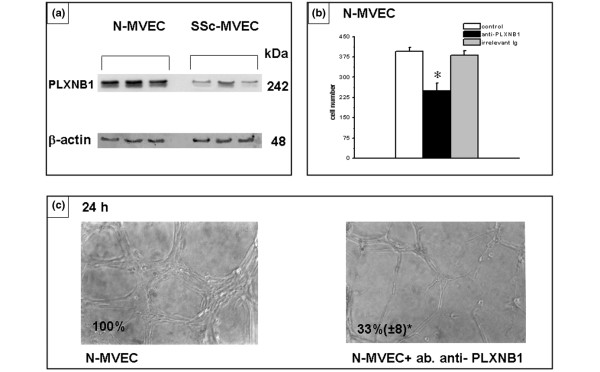
Expression and role of plexin B1 (PLXNB1) in endothelial cell invasion and capillary morphogenesis. (a) Western blotting of 60 μg protein from cell lysates of microvascular endothelial cells (MVECs) from normal subjects (N-MVECs) and patients with systemic sclerosis (SSc-MVECs) with anti-PLXNB1 antibodies. Each lane represents western blotting of MVECs obtained from a single patient. Actin was used as an internal reference standard. Numbers on the right represent the molecular weight expressed in kDa. (b) Effect of anti-PLXNB1 antibodies (3 μg/ml) on matrigel invasion of N-MVECs. The effect of irrelevant rabbit IgG is also shown. Numbers on the x-axis refer to the total number of cells migrated through the matrigel after 6 hours. Data are the mean ± standard deviation of three experiments performed in triplicate in three N-MVEC lines. The asterisk indicates that values are significantly different from the values of control (p < 0.05). (c) Effect of anti-PLXNB1 antibodies on capillary morphogenesis of N-MVECs. N-MVECs were plated on Matrigel (60 × 103/ml), in complete MCDB medium, supplemented with 30% fetal calf serum, and 20 μg/ml endothelial cells growth supplement. N-MVEC spontaneously form anastomosing cords of cells resembling a capillary plexus, which are well organized by 6 hours. The process of endothelial cell organization after 6 hours is impaired in the presence of 3 μg/ml of anti-PLXNB1 rabbit polyclonal antibodies. Irrelevant rabbit IgG gave results similar to control untreated N-MVECs (not shown). These data are representative of three different experiments performed on three N-MVEC cell lines (100× magnification). Numbers reported within each panel indicate the percent of the photographic field occupied by cells ± standard deviation. The asterisk indicates that values are significantly different from the values of control N-MVECs at 6 hours after plating on Matrigel (p < 0.05).